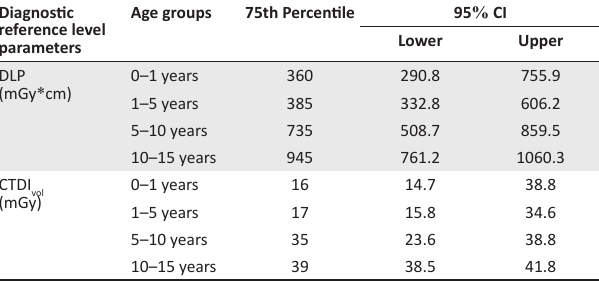
TABLE 4: The 75th percentile dose length product (mGy * cm) and volume-based computed tomography dose index (mGy) values for various age groups.